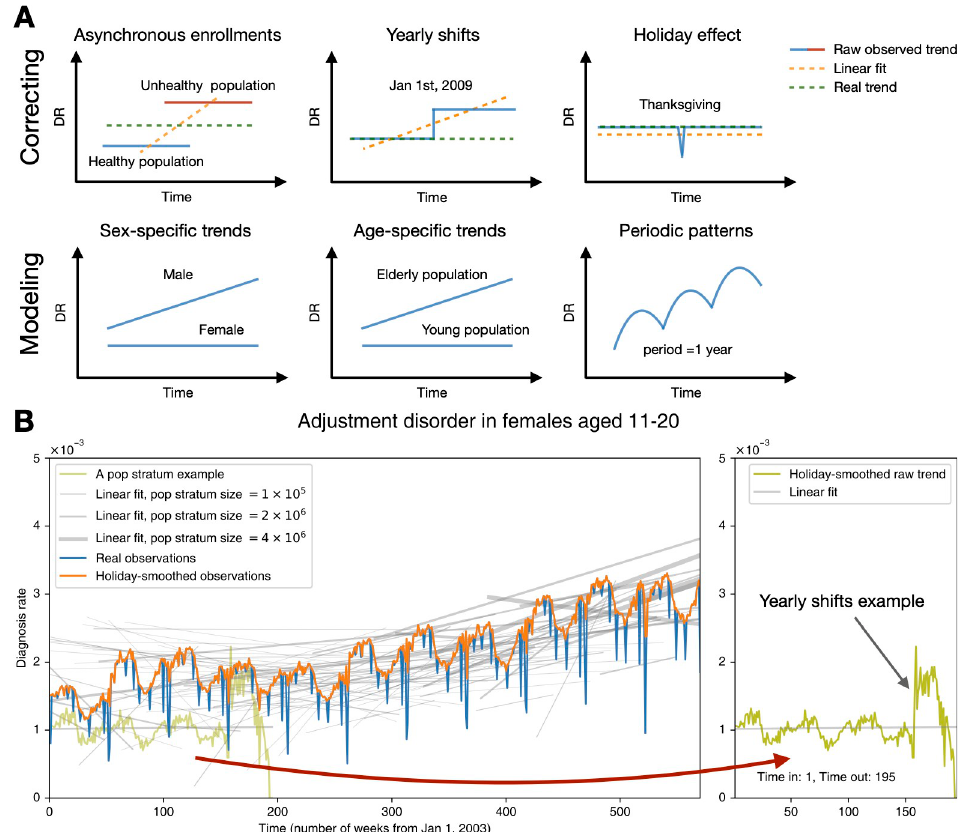
Fig 1. The characteristics of the US data and how it influences our model design. (A) Our modeling aimed to correct biases and noise in the MarketScan database and to infer a latent disease DR trend and seasonality for specific age–sex groups. The upper left panel describes the scenario in which 2 populations—a healthy one (the blue line) and an unhealthy one (the red line)—enrolled in the data at different times. The blue and red lines represent the trend of the DR for the 2 populations. We can see that the healthy population joined and left our data earlier than the unhealthy one. Thus, if we fit a simple linear regression model, the result may lead us to conclude that there is an upward trend of DR. Nonetheless, the real trend is actually constant if we had the ability to collect the data of all time (synchronous enrollment) for both populations. The trend of the linear fit (the orange line) comes from “asynchronous enrollments” of populations in various health statuses. The rest of the panels delineate other scenarios likewise. (B) This subplot shows the overall trend and seasonality for a sample disease. The holiday-smooth function offsets the effect of holidays and celebrations that decrease the DR sharply (the orange curve vs. the blue curve). Bear in mind that patients joined and left our US data asynchronously. The gray lines illustrate varying linear fit trends of population strata, defined according to their enrollment dates (see the Methods and techniques part of the Materials and methods section). Some population strata include more people, while others are smaller in size, as marked by the gray lines’ different widths. A sample population stratum enrolled from week 1 to 195 is highlighted in the right panel. Notice that the sudden shift still exists—even for a population with a consistent composition, meaning that the shifts do not result from enrollment changes. The data underlying this figure can be found in https://doi.org/10.5061/dryad.vdncjsxv6. D AU : AbbreviationlistshavebeencompiledforthoseusedthroughoutFigs 1 (cid:0) 4 and 6 (cid:0) 8 : Pleaseverifythatallentriesarecorrect : R, diagnosis